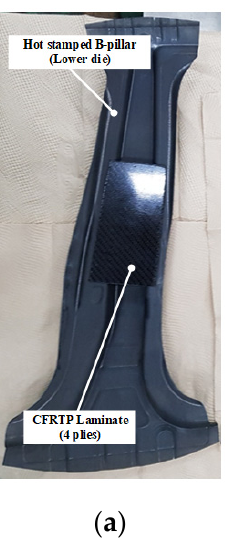
Figure 14. Observation of defects at different tool temperatures. ( a ) 90 °C. ( b ) 110 °C. ( c ) 130 °C.